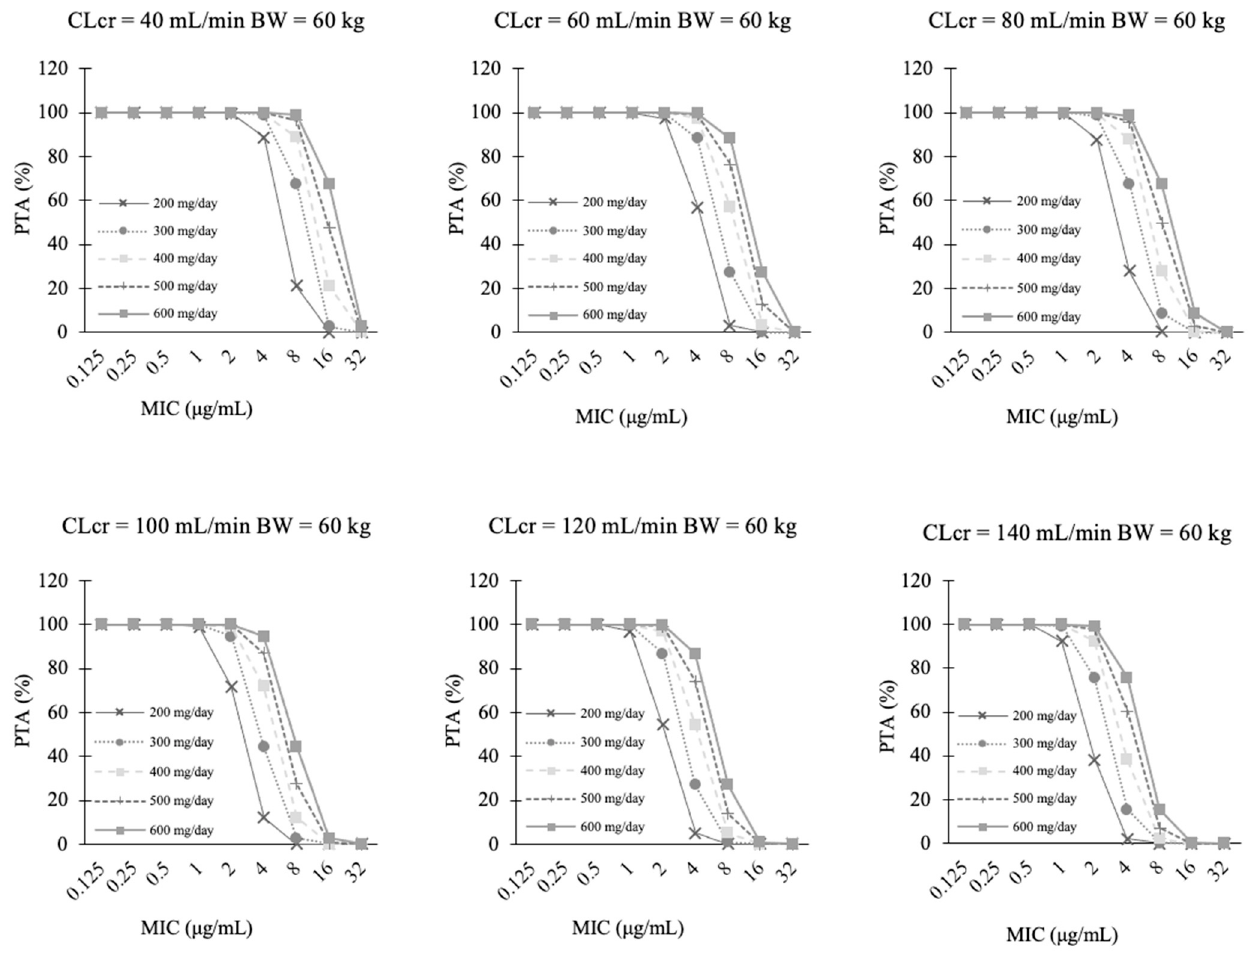
Figure 4. Probability of target attainment (PTA) of f AUC/MIC ratio ≥ 50 after fluconazole maintenance doses of 200 mg, 300 mg, 400 mg, 500 mg, and 600 mg administered on Day15 (336–360 h). Target MIC is 2 μ g/mL, and Body Weight is 60 kg. Other Body Weight is shown in Figure S2. Table 4. Nomogram of fluconazole dose for